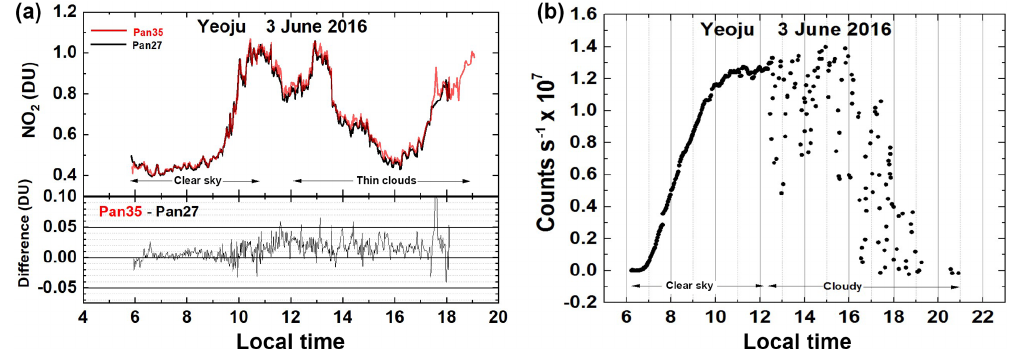
Figure 2. (a) C ( NO 2 ) amounts from Pandora 27 and 35 in Yeoju, Korea during 3 June 2016 and their difference | Pan35–Pan27 | < 0.05DU. (b) Pandora 35 estimate of cloud or aerosol reduced measured countss − 1 at approximately